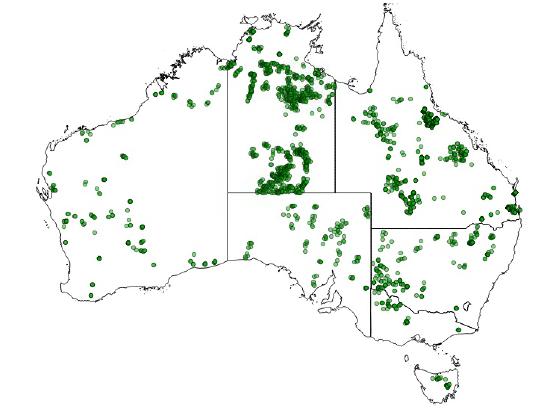
Figure 1. Location of field calibration and validation sites which are used by the JRSRP to develop land cover products.